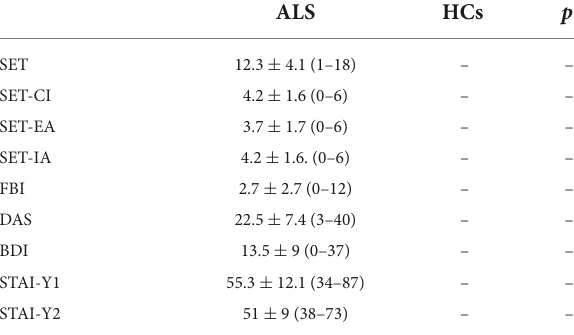
TABLE 1 Background and cognitive measures of participants.